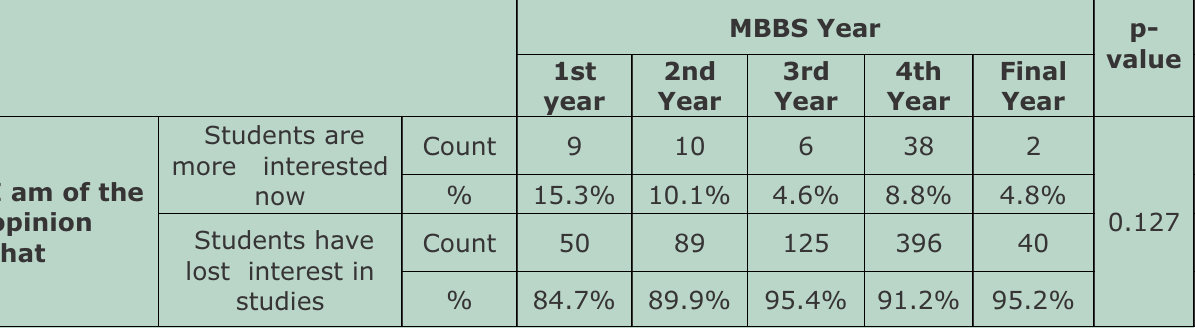
Table-IV: Prevalence of Students' interest during pandemic according to MBBS classes.